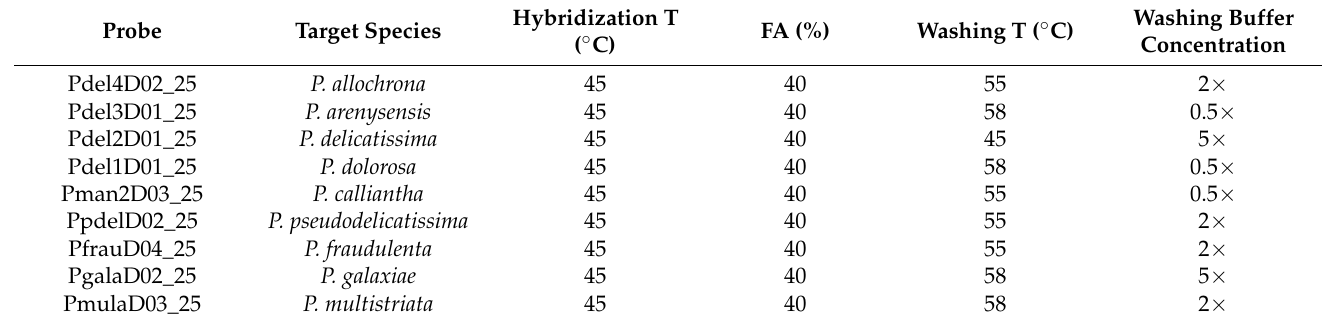
Table 4. WC-FISH optimization. Hybridization temperature, formamide concentration (FA), temperature, and concentration of post-hybridization buffer to avoid cross-hybridization of the selected